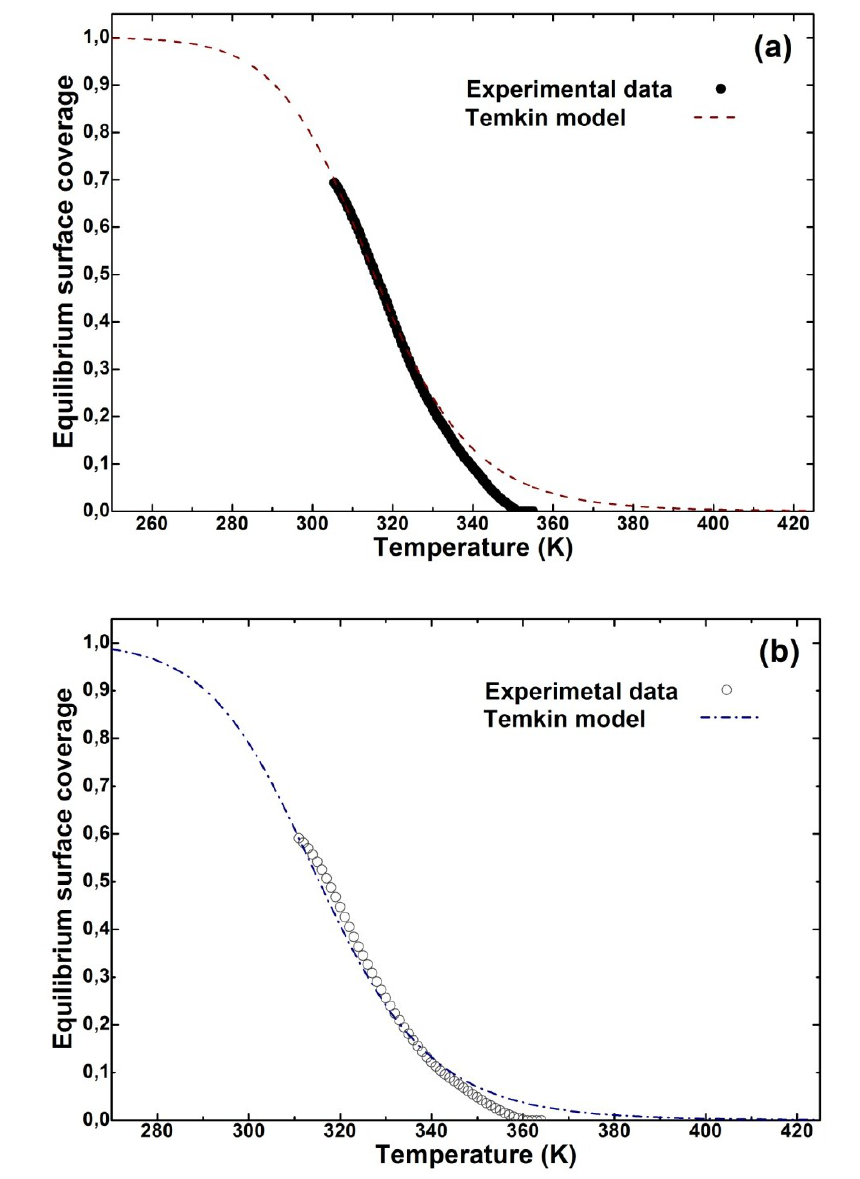
Figure 6. Confrontation of the evolution of o -xylene equilibrium coverage with the Temkin model during a TPAE experiment carried out with bentonite ( a ) and ( b ) with